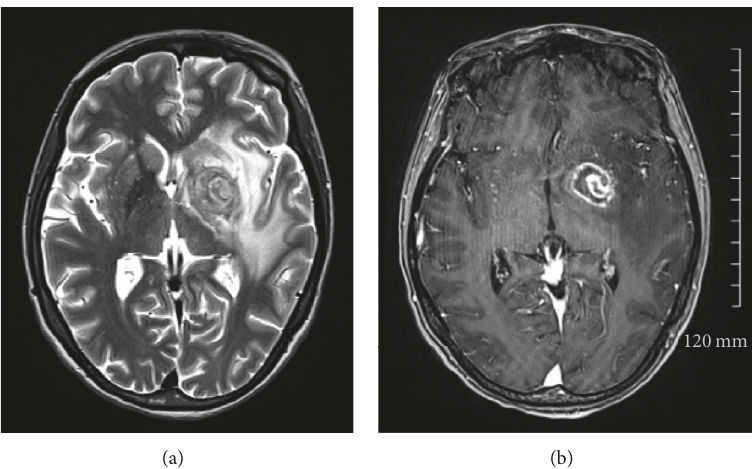
Figure 1: (a) T2 sequence demonstrating “concentric” target sign with concentric alternating hypointense and hyperintense rims. (b) Postcontrast sequence demonstrating “eccentric” target sign with a peripheral rim of enhancement and focal left lateral eccentric enhancing nodule.